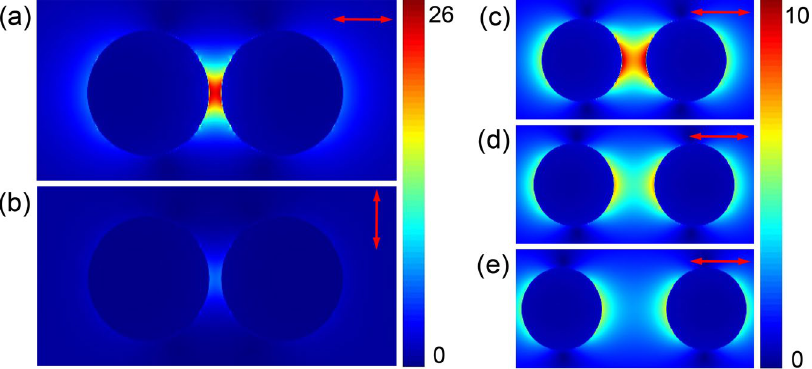
Figure 3. Plots of light field magnitude (|E|, λ = 800 nm) of a GNS dimer structure with incident polarisation ( a ) parallel and ( b ) perpendicular to the interparticle axis and a 10 nm gap, ( c – f ) parallel to the interparticle axis and a gap of ( c ) 30 nm, ( d ) 50 nm, and ( e ) 80 nm, respectively. Arrows indicate incident light